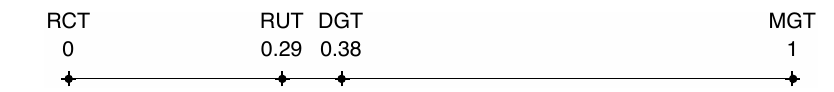
Figure 5. Normalized multidimensional scaling scores from each of the four treatments mapped onto a unidimensional solution. This analysis yields the relative similarity (behavioral consistency) among the different